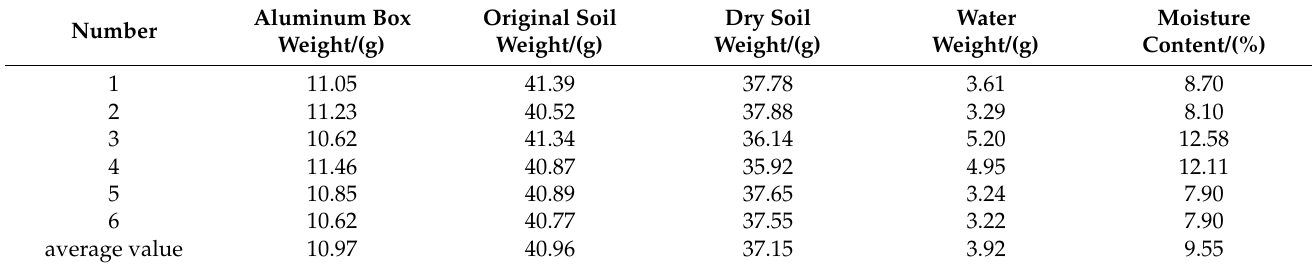
Table 2. Content of the soil.